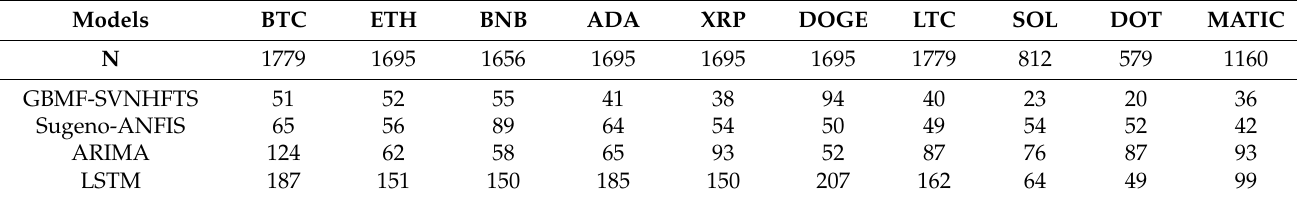
Table 5. A computation time comparison between the proposed GBMF-SVNHFTS method and existing methods.